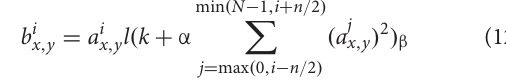
operation in the convolution layer. All convolutional